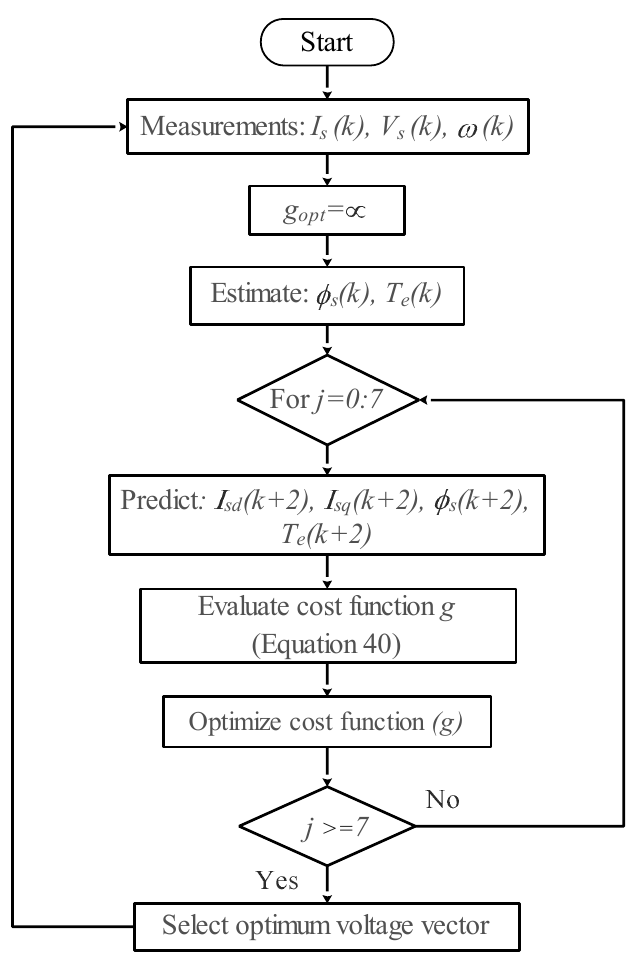
Figure 11. Flowchart of the proposed MPDTC technique.